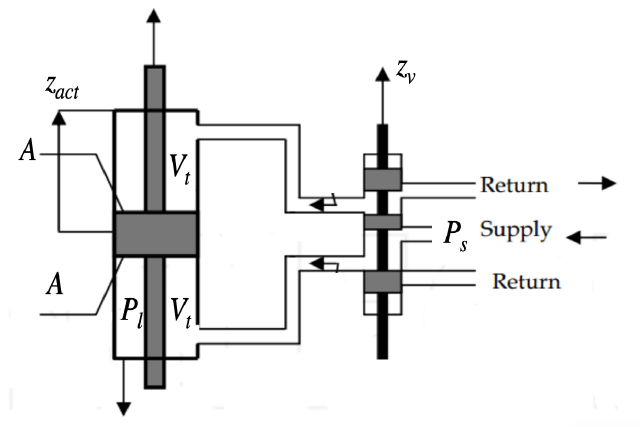
Figure 2. Electro-Hydraulic